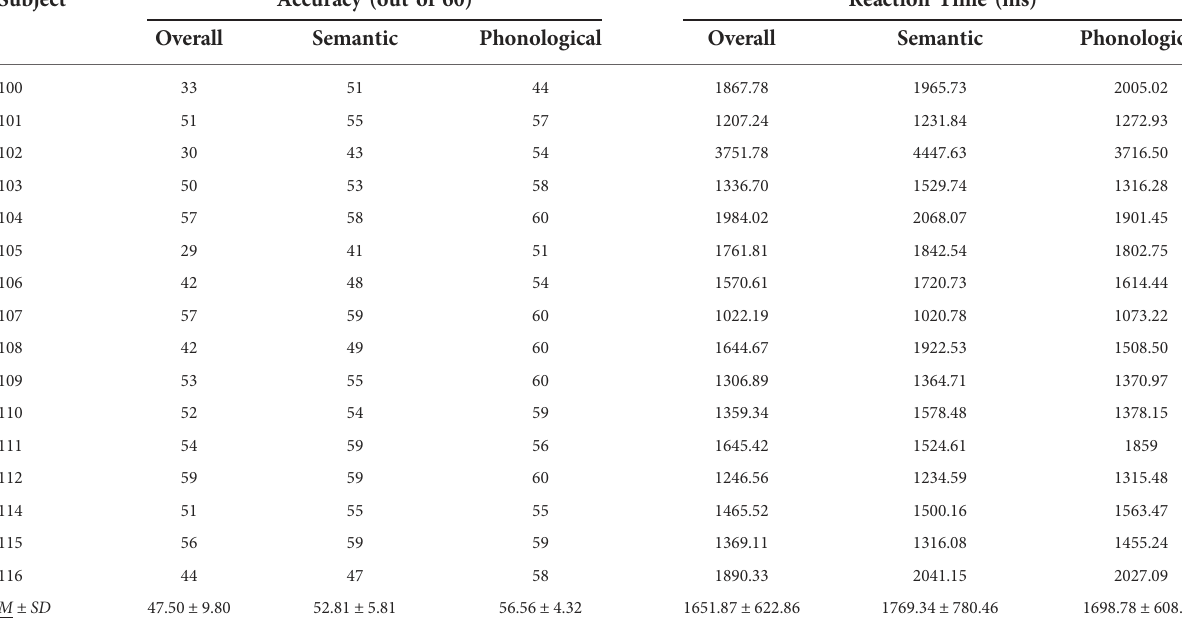
TABLE 3 aWPVT raw accuracy and mean response latency performance.